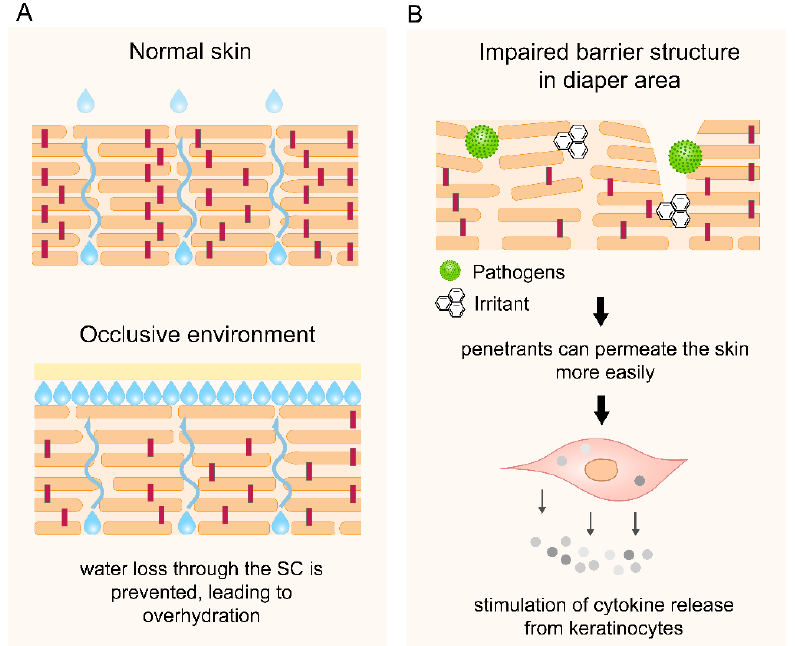
Figure 4. Skin permeability disruption of the diaper area. Occlusion of the SC ( A ) induced impaired skin barrier and increased skin permeability of penetrants ( B ), leading to an immunological re ‐ sponse.